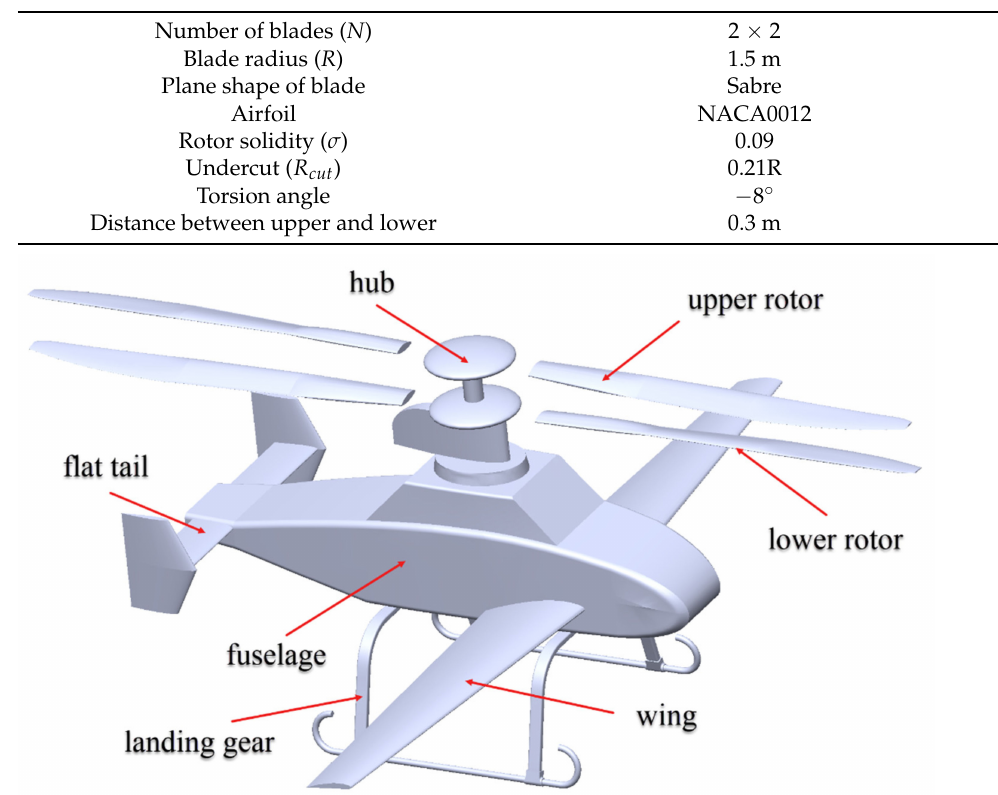
Figure 9. Schematic diagram of the compound coaxial helicopter.